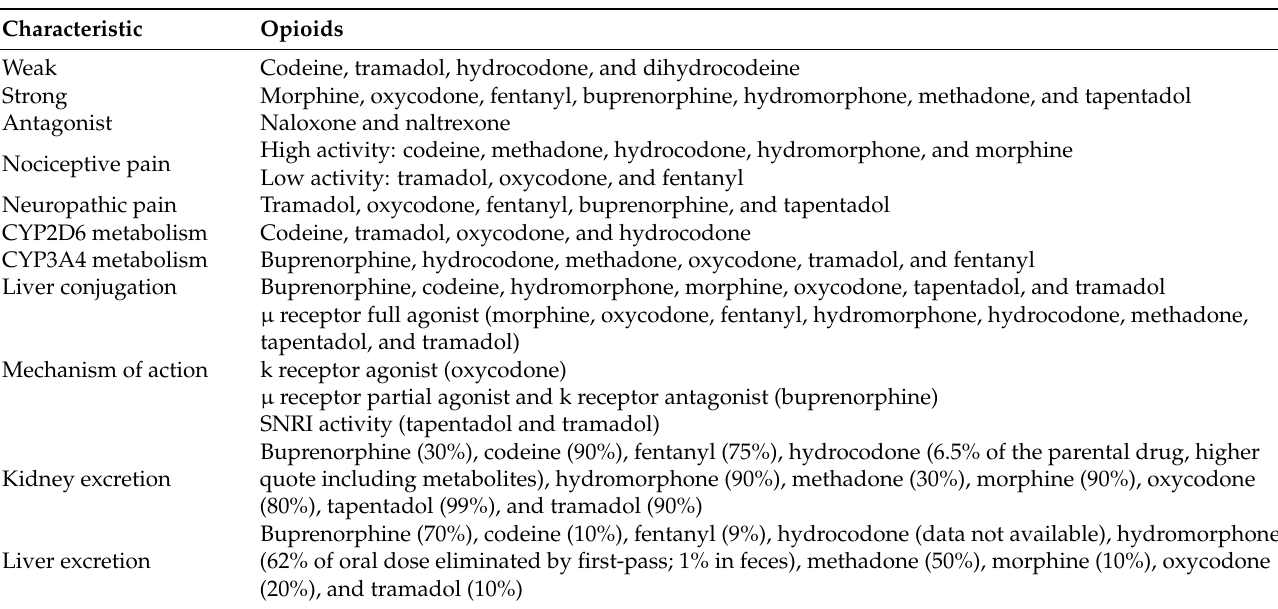
Table 1. Opioids characteristics [11,12]. SNRIs: serotonin–norepinephrine reuptake